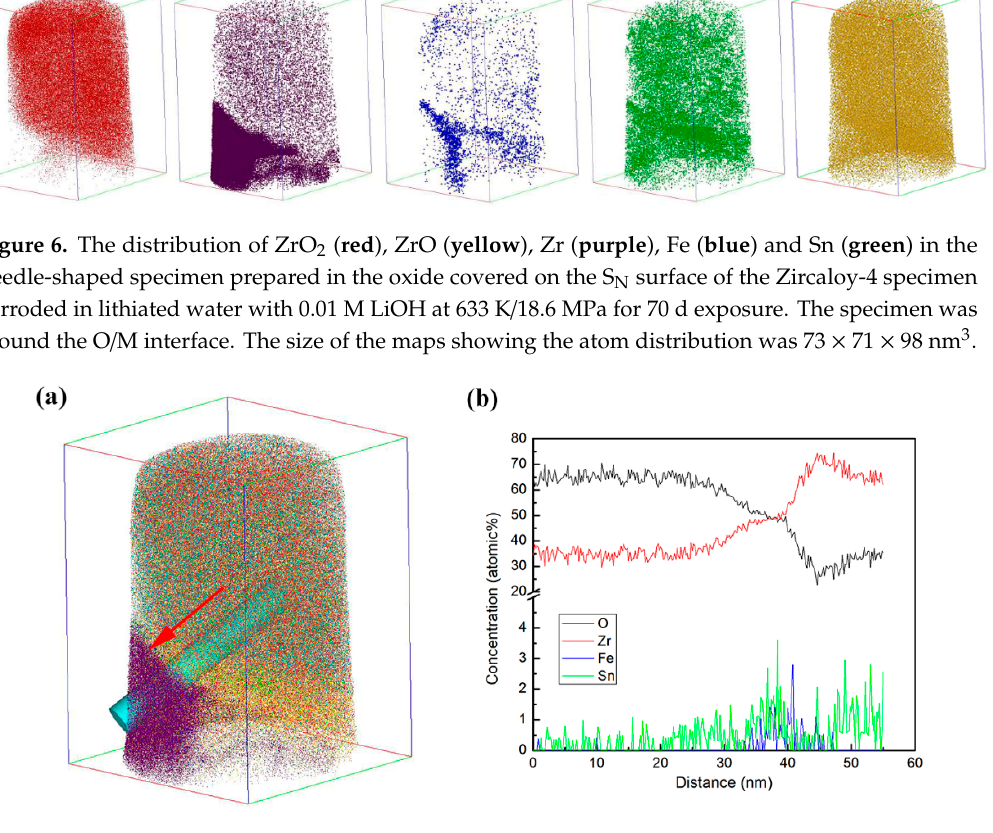
Figure 7. A 3D map of all the substances’ atoms, ZrO 2 (red), ZrO (yellow), Zr (purple), Fe (blue) and Sn (green) in needle-shaped specimen prepared in the oxide covered on the S N surface of the Zircaloy-4 specimen after corroding in lithiated water with 0.01 M LiOH at 633 K / 18.6 MPa for 70 d. The specimen was around the O / M interface. The size of maps showing the atom distribution was 73 × 71 × 98 nm 3 . The analysis cylinder (10 nm in diameter) is signed in the graph, and the arrow indicates the analysis direction ( a ). The concentration curves of Zr, O, Fe and Sn in the analysis cylinder ( b ).